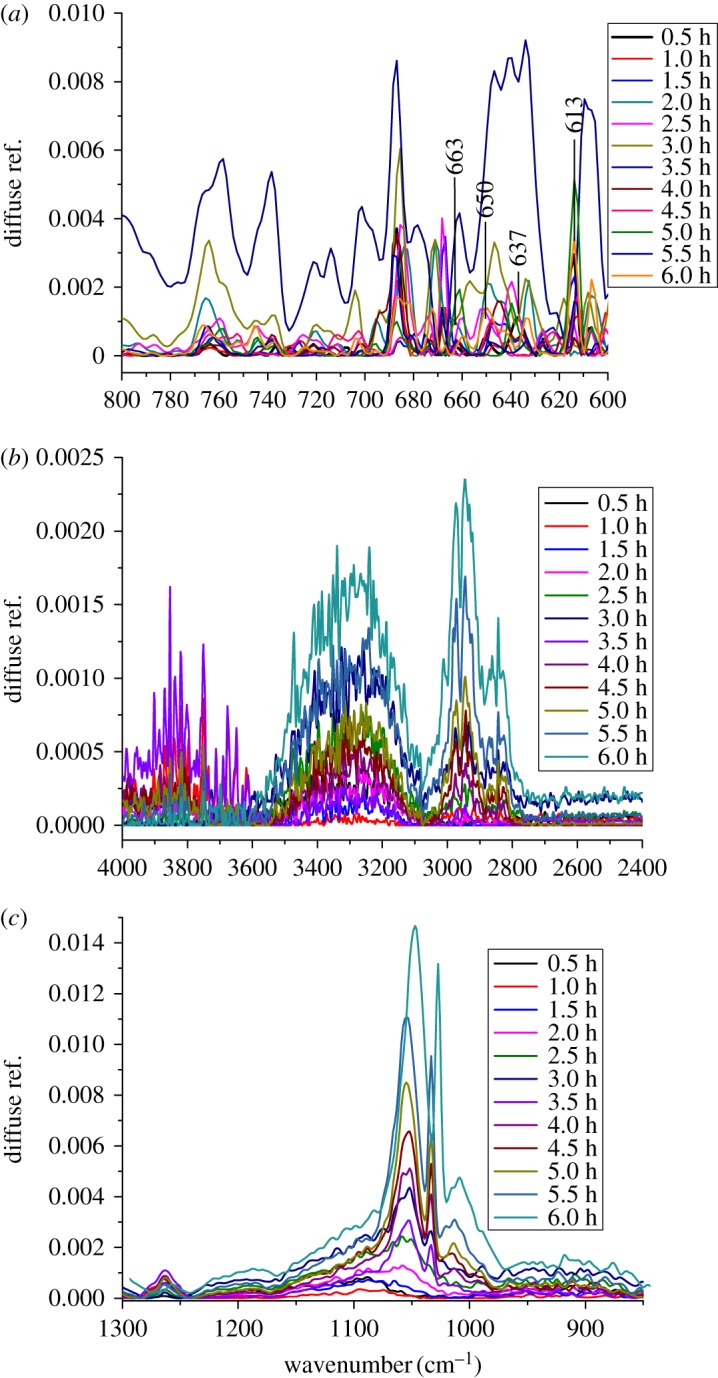
In situ DRIFTS spectra of naphthalene and H2O2 on Fe3O4 surface.